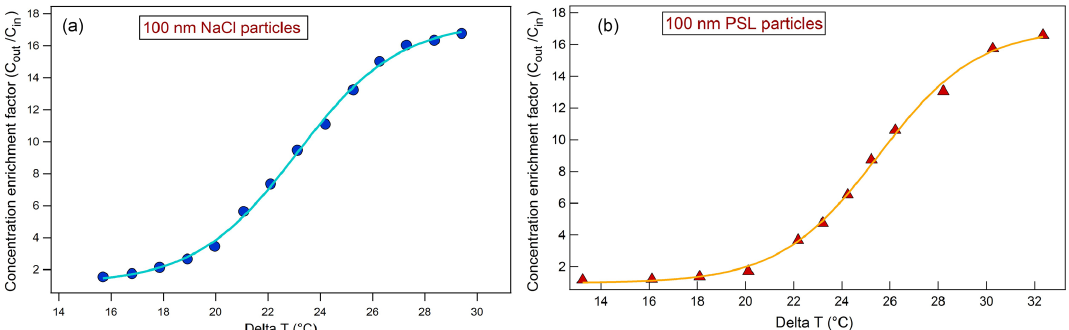
Figure 2. (a) Experimentally determined concentration enrichment factor for 100nm NaCl particles at different (cid:49)T (difference between the saturator temperature T s and the condenser temperature T c ). (b) Experimentally determined concentration enrichment factor for 100nm PSL particles as a function of (cid:49)T . The maximum experimental enrichment factors correspond to 100%